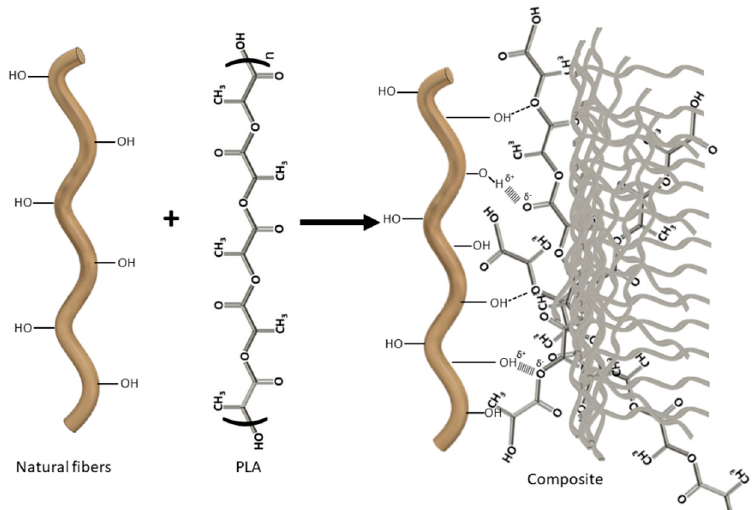
Figure 2. Theoretical scheme showing the potential interactions between BKSF and PLA.